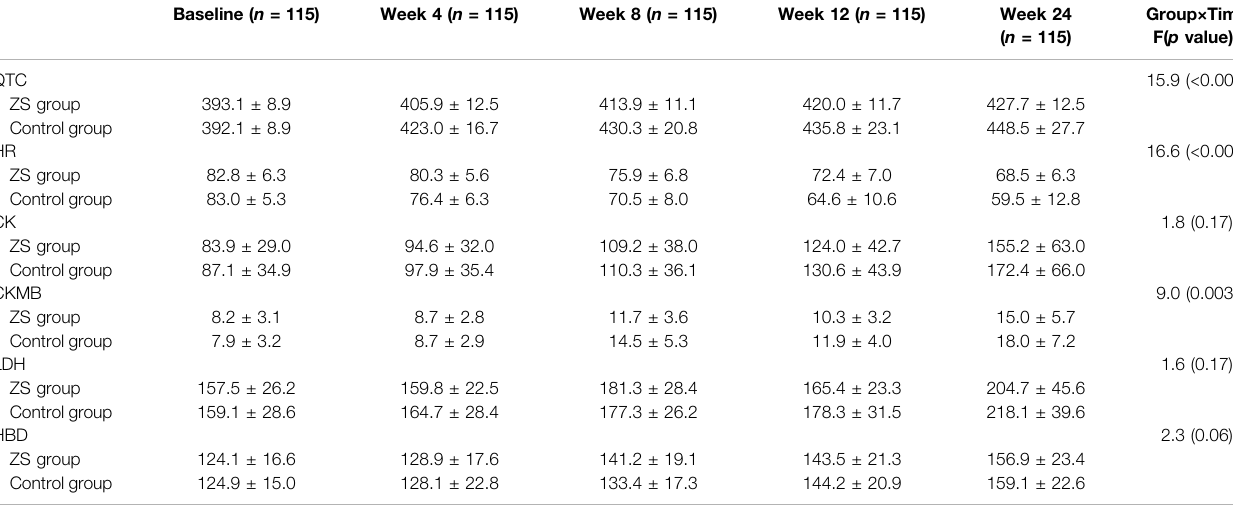
TABLE 3 | QTc and cardiac biomarkers at baseline, week 4, week 8, week 12 and week 24 in ZS group and control group (mean ± standard deviations).